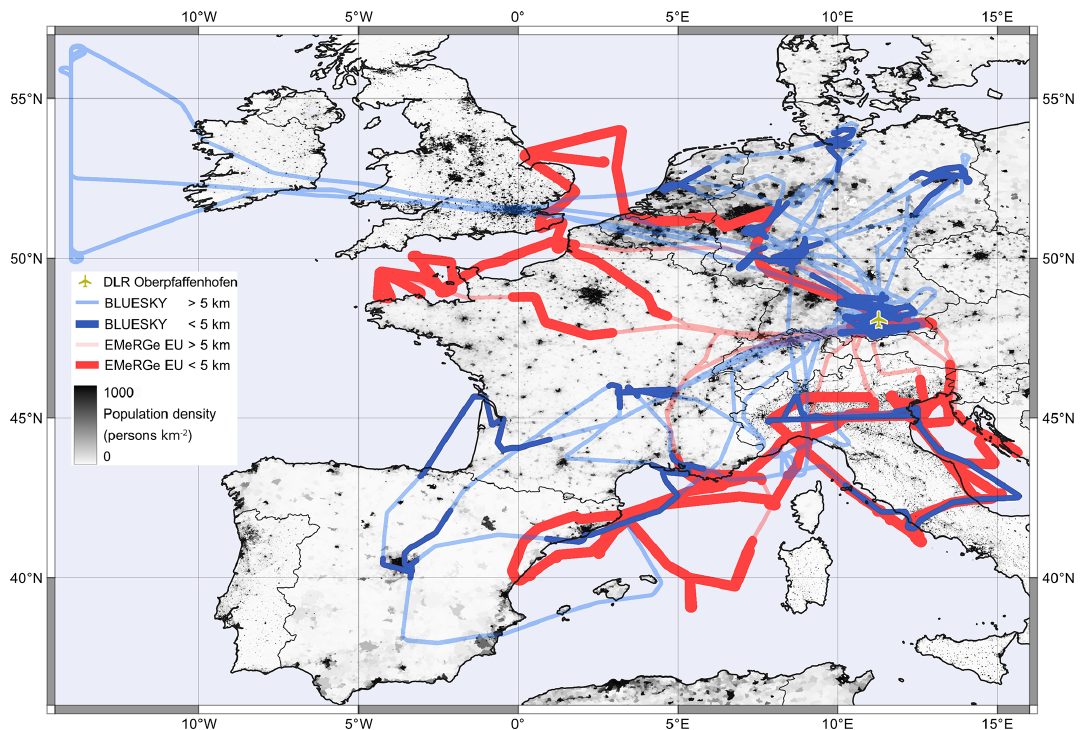
Figure 1. Flight tracks of the HALO EMeRGeEU (in July 2017, Andrés Hernández et al., 2022) and BLUESKY (in May and June 2020, Voigt et al., 2022) aircraft campaigns. Both campaigns were conducted from the DLR airport in Oberpfaffenhofen in southern Germany. Flight segments with altitudes below 5km, which yielded the measurement data for this study, are highlighted in the map. The population density is for the year 2020 (CIESIN,